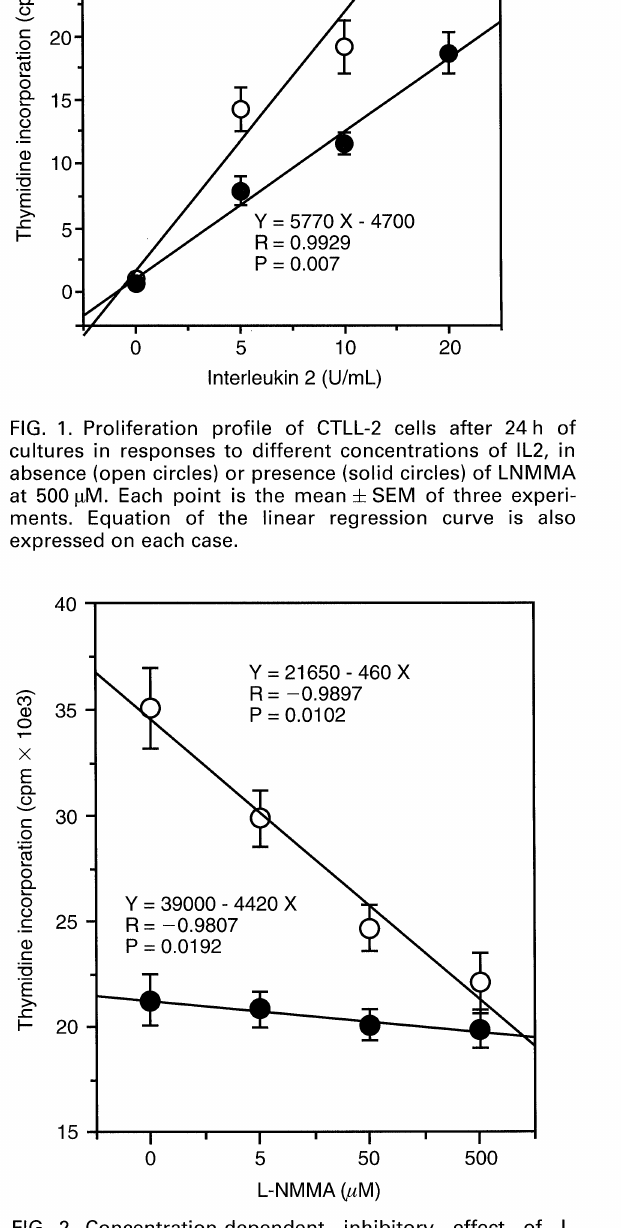
FIG. 2. Concentration-dependent inhibitory effect of L- NMMA upon IL2 (20 U/ml)-induced proliferation on CTLL-2 cells, in presence (2 mM) (open circles) or absence (solid circles) of L-arginine. The absence of L-arginine was as potent as L-NMMA (500#M) for reducing CTLL-2 cells proliferation. Each point is the mean 4- SEM of three experi- ments. Equation of the linear regression curve is also expressed on each